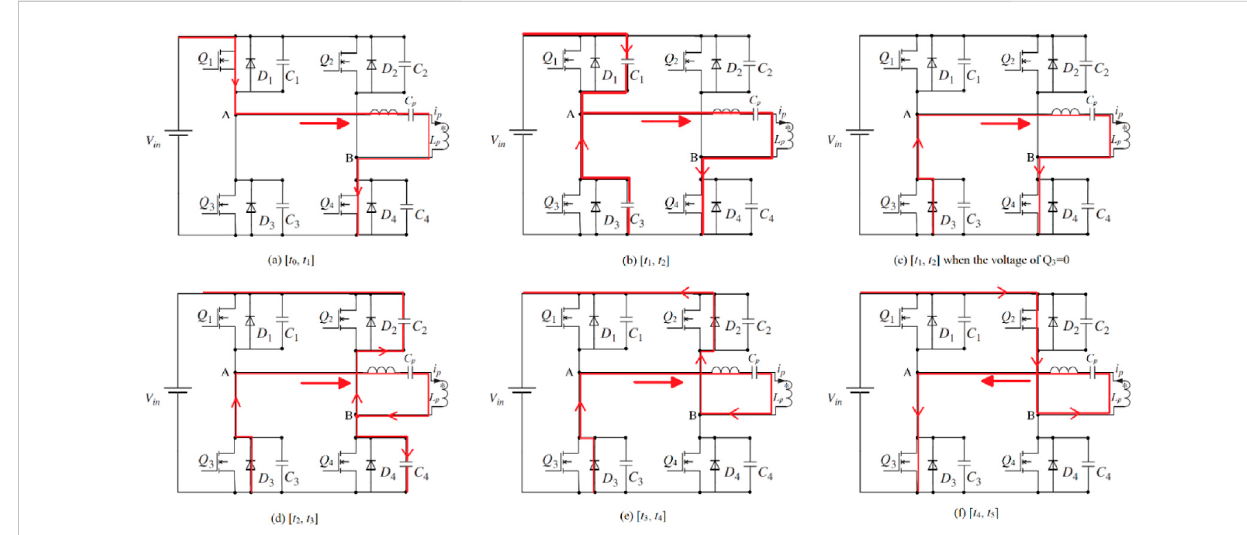
FIGURE 7 Equivalent circuits of different switching modes in soft-switching condition.